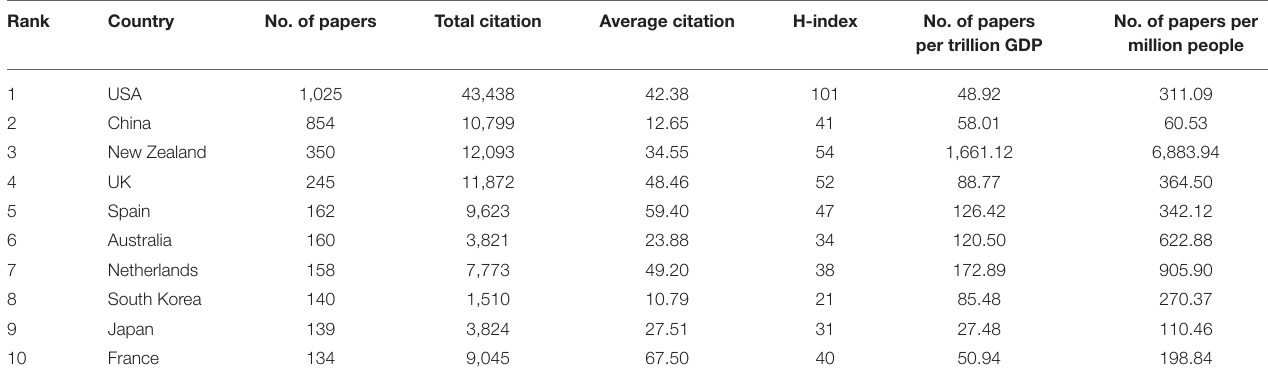
TABLE 1 | Top 10 countries with the most